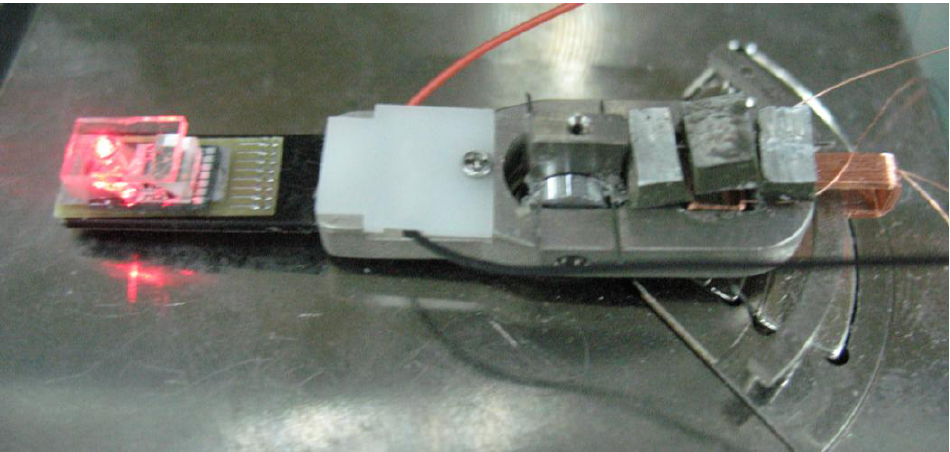
Figure 14. Prototype of the dual-stage seesaw